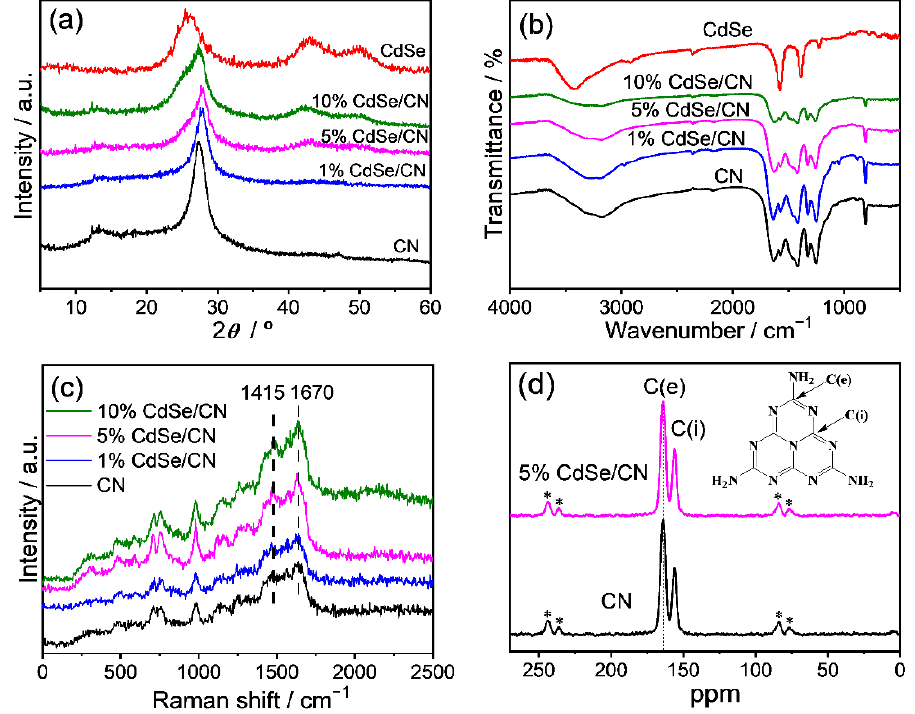
Figure 3. ( a ) XRD patterns, ( b ) FTIR spectra, ( c ) UV–Raman spectra, and ( d ) solid-state 13 C NMR spectra of CdSe/CN composite and CN nanorods. The stars (*) correspond to the spinning side- bands.